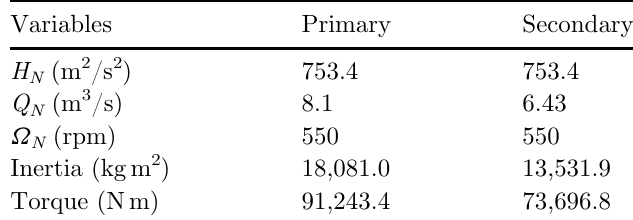
Table 4. Characteristics pump parameters